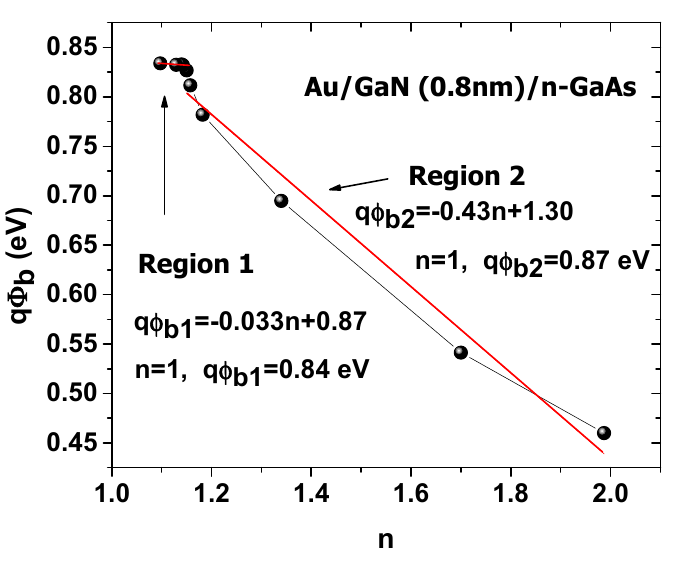
Figure 7. ɸ b versus n .